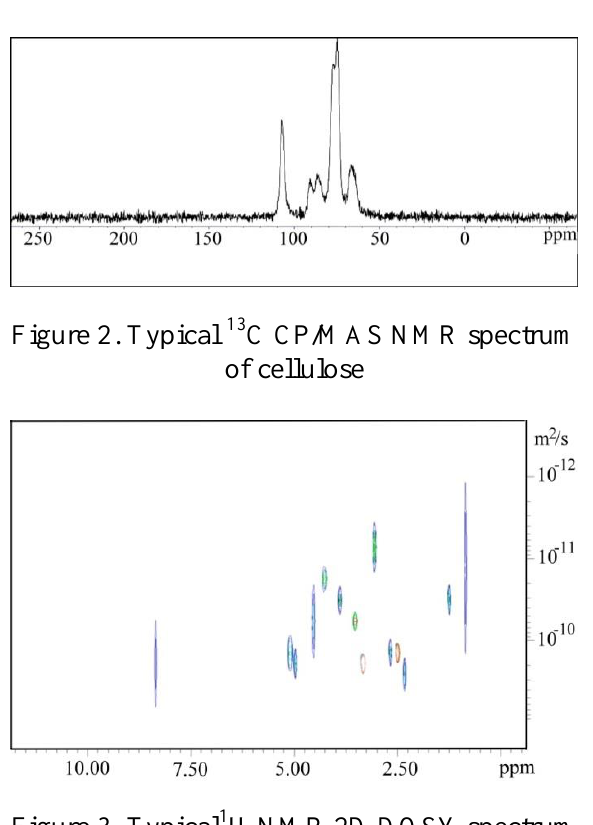
Figure 3. Typical 1 H NMR 2D DOSY spectrum of cellulose